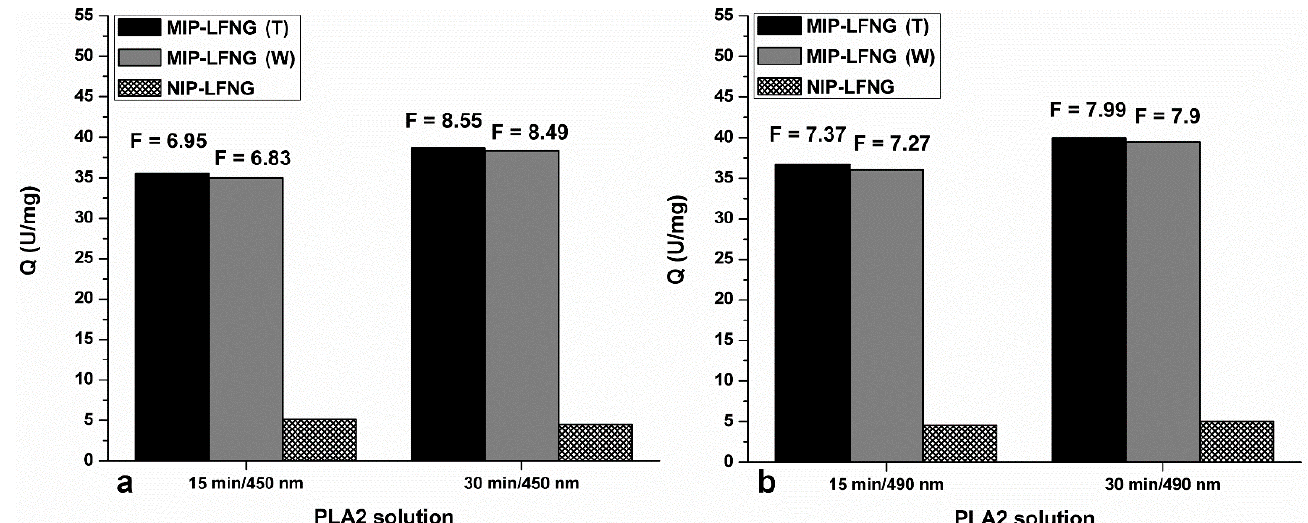
Figure 4. Rebinding capacity, Q, and imprinting factor, F, of LFNGs exposed to PLA2 solution after 15 and 30 min and evaluated at ( a ) 450 nm and ( b ) 490 nm.